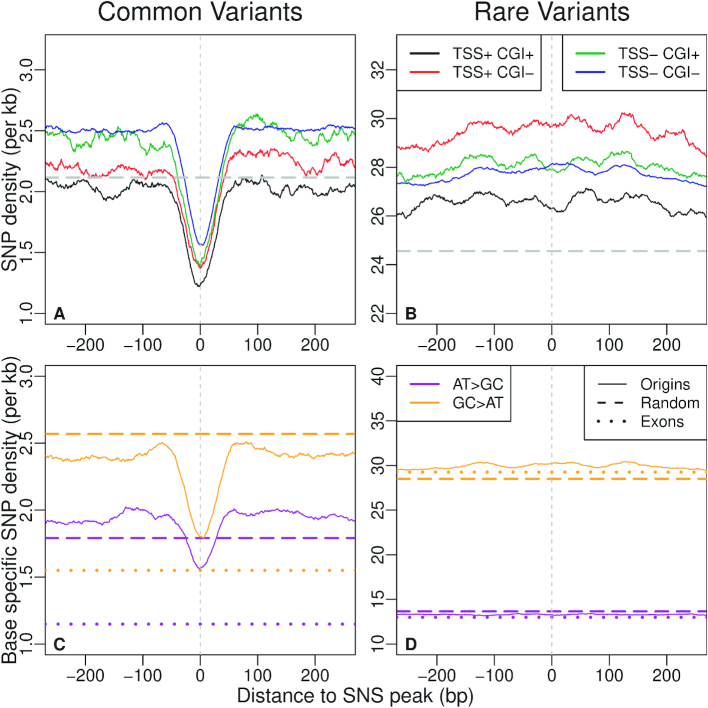
Density of genetic polymorphism around origins: average SNP density in the vicinity of all human SNS peaks (plain lines) for different classes of origins, depending on their association with CGI and/or TSSs. Genome-wide averages are indicated by broken lines. (A) Common variants (DAF > 10%). (B) Rare variants (DAF < 1%). (C, D) Base-specific SNP density (see Materials and Methods section) in the vicinity of all human SNS peaks (plain line). Broken lines: genome-wide average. Dotted line: average base-specific SNP density in all human coding exons. (C) Common A or T to C or G (\documentclass[12pt]{minimal}
\usepackage{amsmath}
\usepackage{wasysym}
\usepackage{amsfonts}
\usepackage{amssymb}
\usepackage{amsbsy}
\usepackage{upgreek}
\usepackage{mathrsfs}
\setlength{\oddsidemargin}{-69pt}
\begin{document}
}{}${\texttt {A}}{\texttt {T}}>{\texttt {C}}{\texttt {G}}$\end{document}) and C or G to A or T (\documentclass[12pt]{minimal}
\usepackage{amsmath}
\usepackage{wasysym}
\usepackage{amsfonts}
\usepackage{amssymb}
\usepackage{amsbsy}
\usepackage{upgreek}
\usepackage{mathrsfs}
\setlength{\oddsidemargin}{-69pt}
\begin{document}
}{}${\texttt {C}}{\texttt {G}}>{\texttt {A}}{\texttt {T}}$\end{document}) variants (DAF > 10%). (D) Rare variants (DAF < 1%).